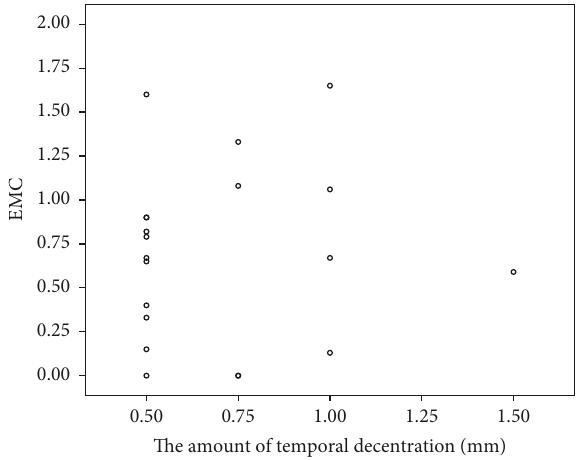
Figure 4: Box plot for comparison about mean axial length growth per year between OLD group and OLC group.